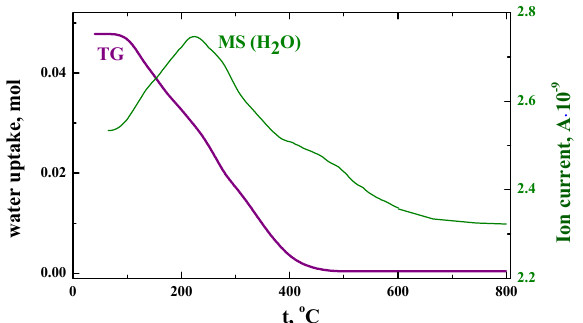
Figure 3. TG- and MS(H 2 O)-results for hydrated SrLa 2 Sc 2 O 7 composition. The electrical conductivity values were collected using the impedance spectroscopy method. The EIS plots for the SrLa 2 Sc 2 O 7 composition obtained at different temperatures are presented in Figure 4. All EIS plots consist of two semicircles. The fitting of the spec- tra was made using ZView software (Scribner, Southern Pines, NC, USA), and the ob- tained results are presented in Table 3. The first (high-frequency) corresponds to volume